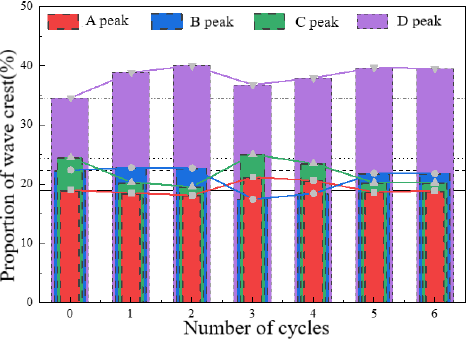
Figure 11. Proportion of each wave peak as the number of freeze–thaw cycles increases.